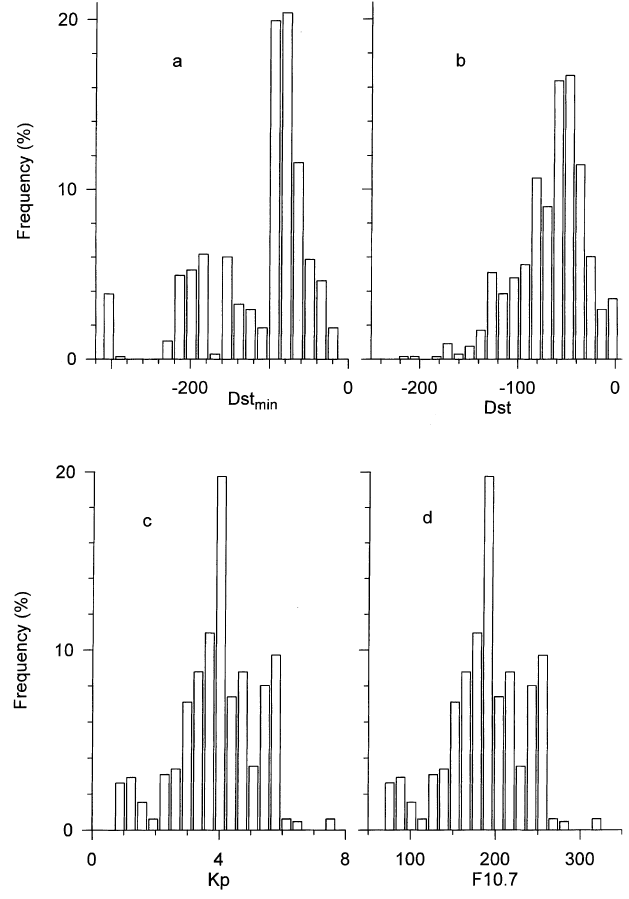
Fig. 2a–d. Histograms for indices a Dst min , b Dst , c Kp , and d F 10 : 7 characterizing solar and geomagnetic activity during SAR arc events involved in the